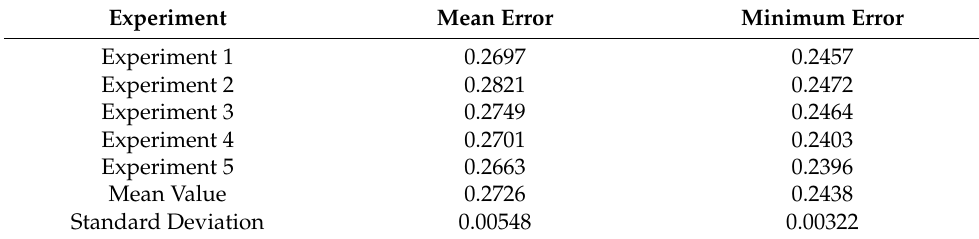
Table 18. Mean and standard deviation of 5 experiments on Five